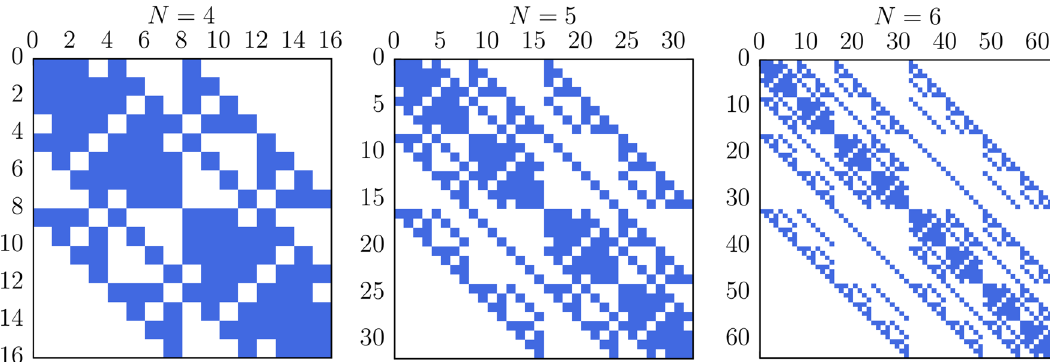
ˆ Q for N = 4 , 5 and 6. White corresponds to zero-valued elements